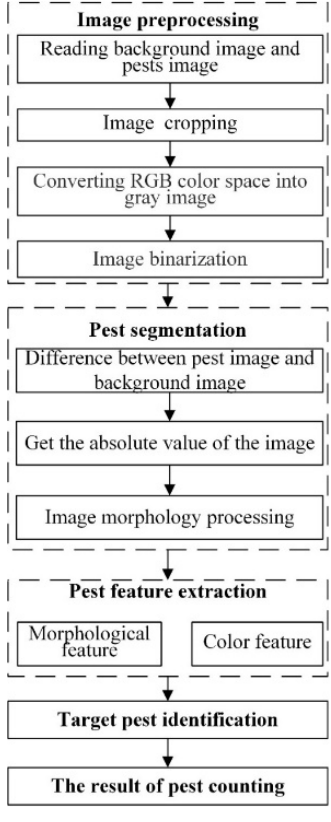
Figure 6. Processing fl ow of pest image.